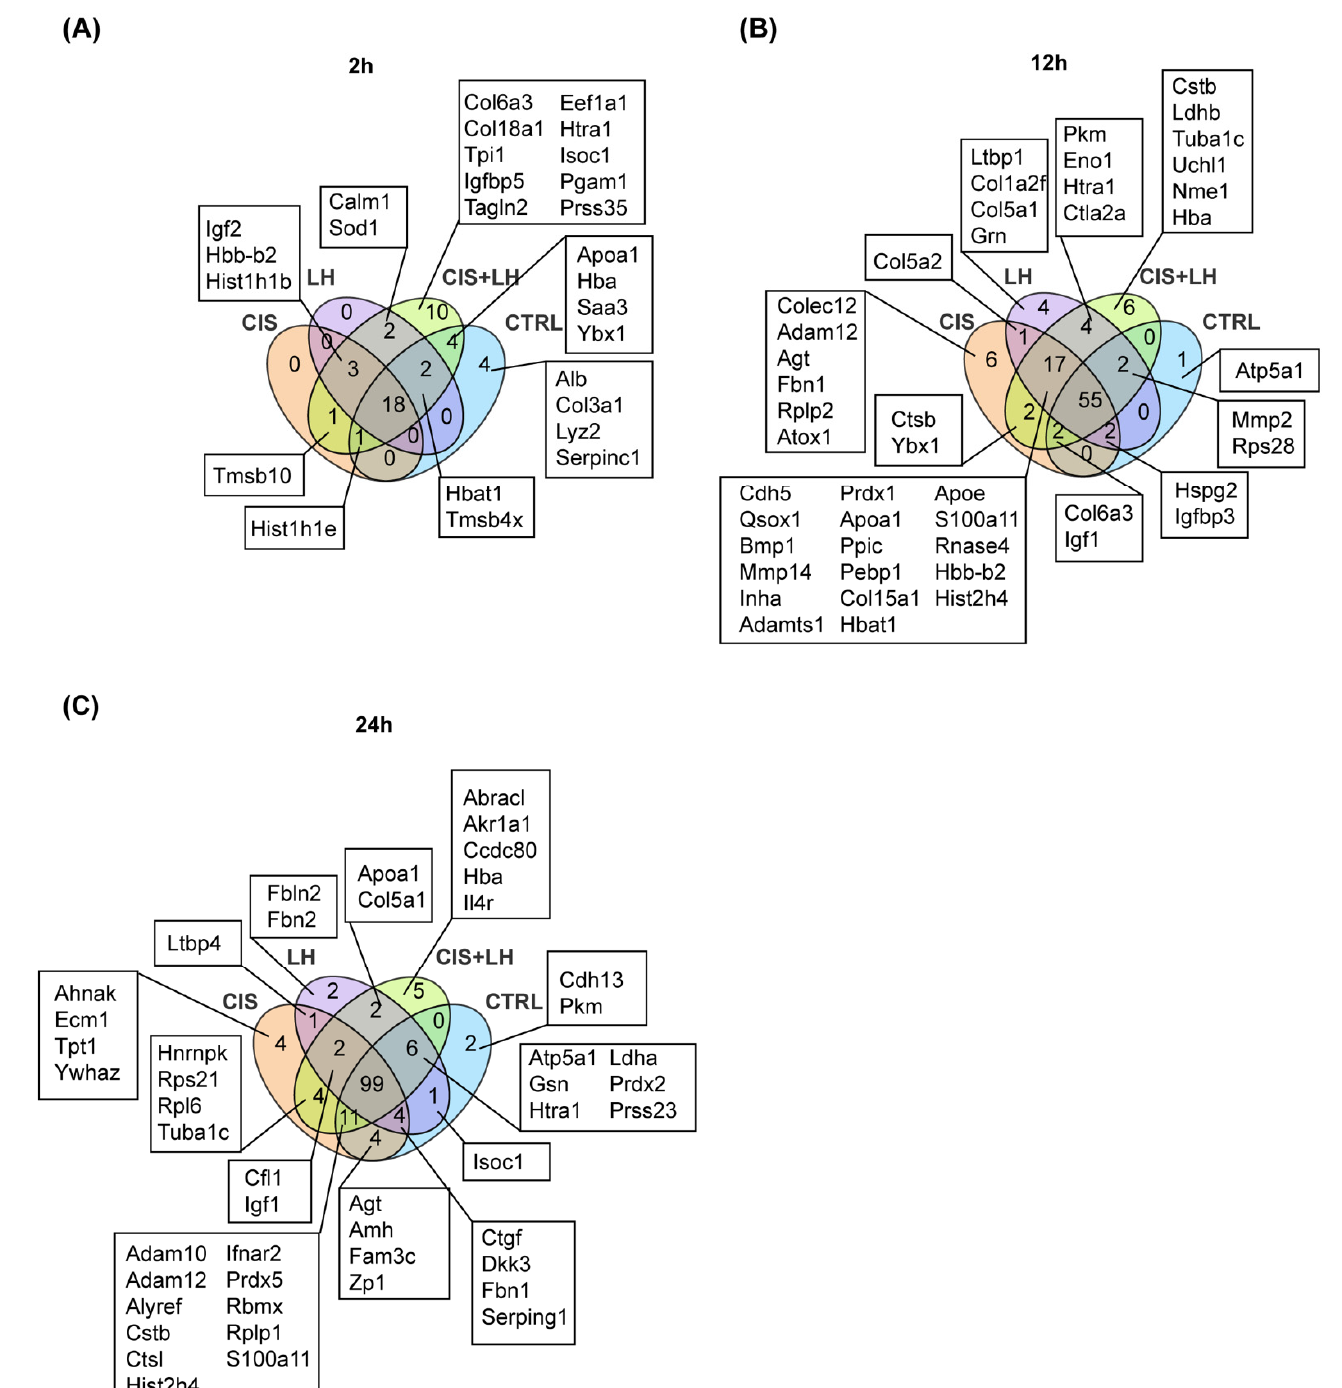
Figure 5. Venn diagram showing unique and shared proteins between all experimental conditions. The numbers indicate the metabolites counts in the indicated area. The metabolites are indicated below the diagram for each category, except for those shared among all groups (reported in Table S3). ( A ) Overlaps between CTRL, LH, CIS, and CIS + LH at 2 h of treatment. ( B ) Overlaps between CTRL, LH, CIS, and CIS + LH at 12 h of treatment. ( C ) Overlaps between CTRL, LH, CIS, and CIS + LH at 24 h of treatment.